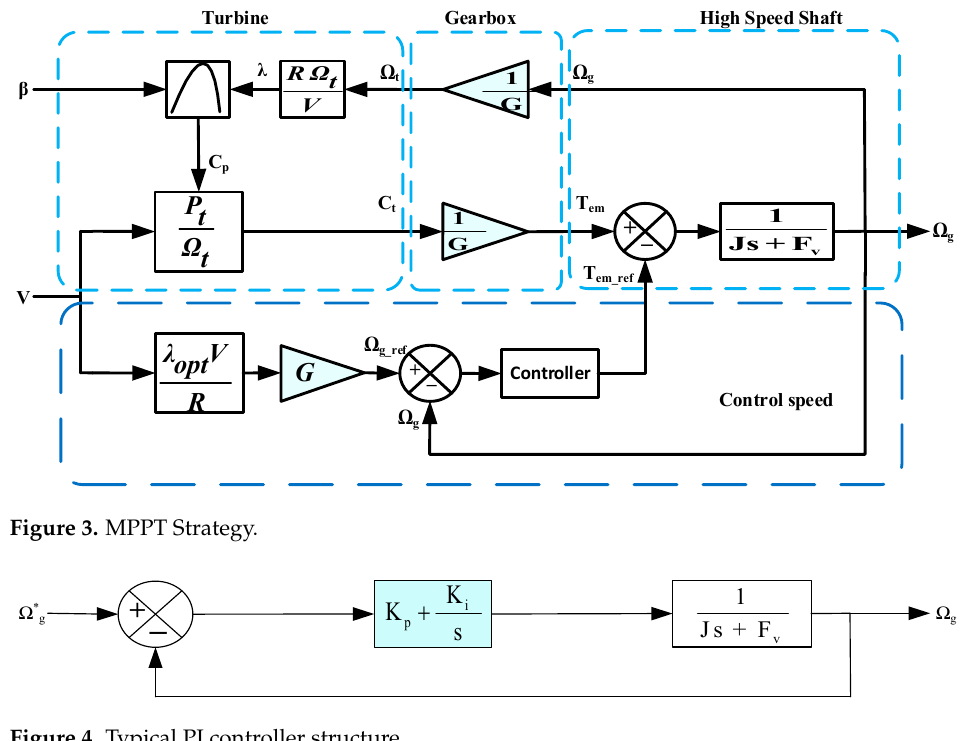
Figure 3. MPPT Strategy.